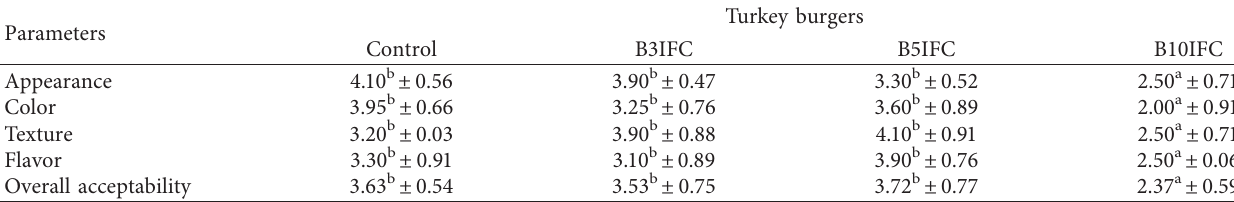
Table 7: Sensory properties of cooked turkey burgers formulated with IFC.